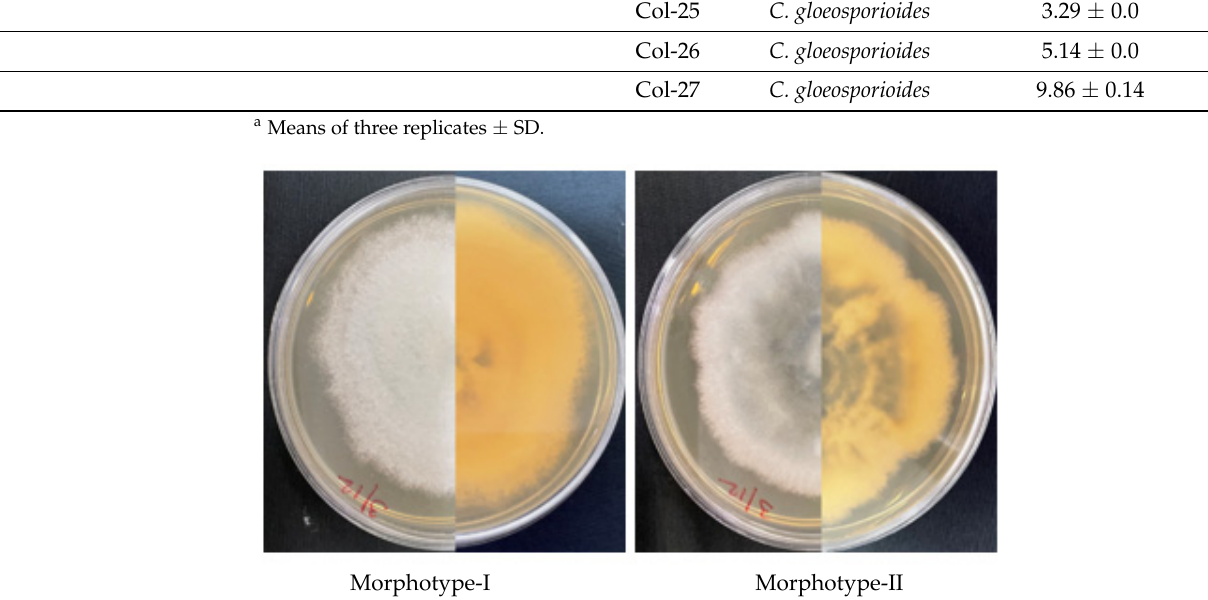
Figure 2. Representative morphotypes of Alternaria isolates characterized in the current study. Front and back of seven-day-old colonies grown on PDA at 25 °C.